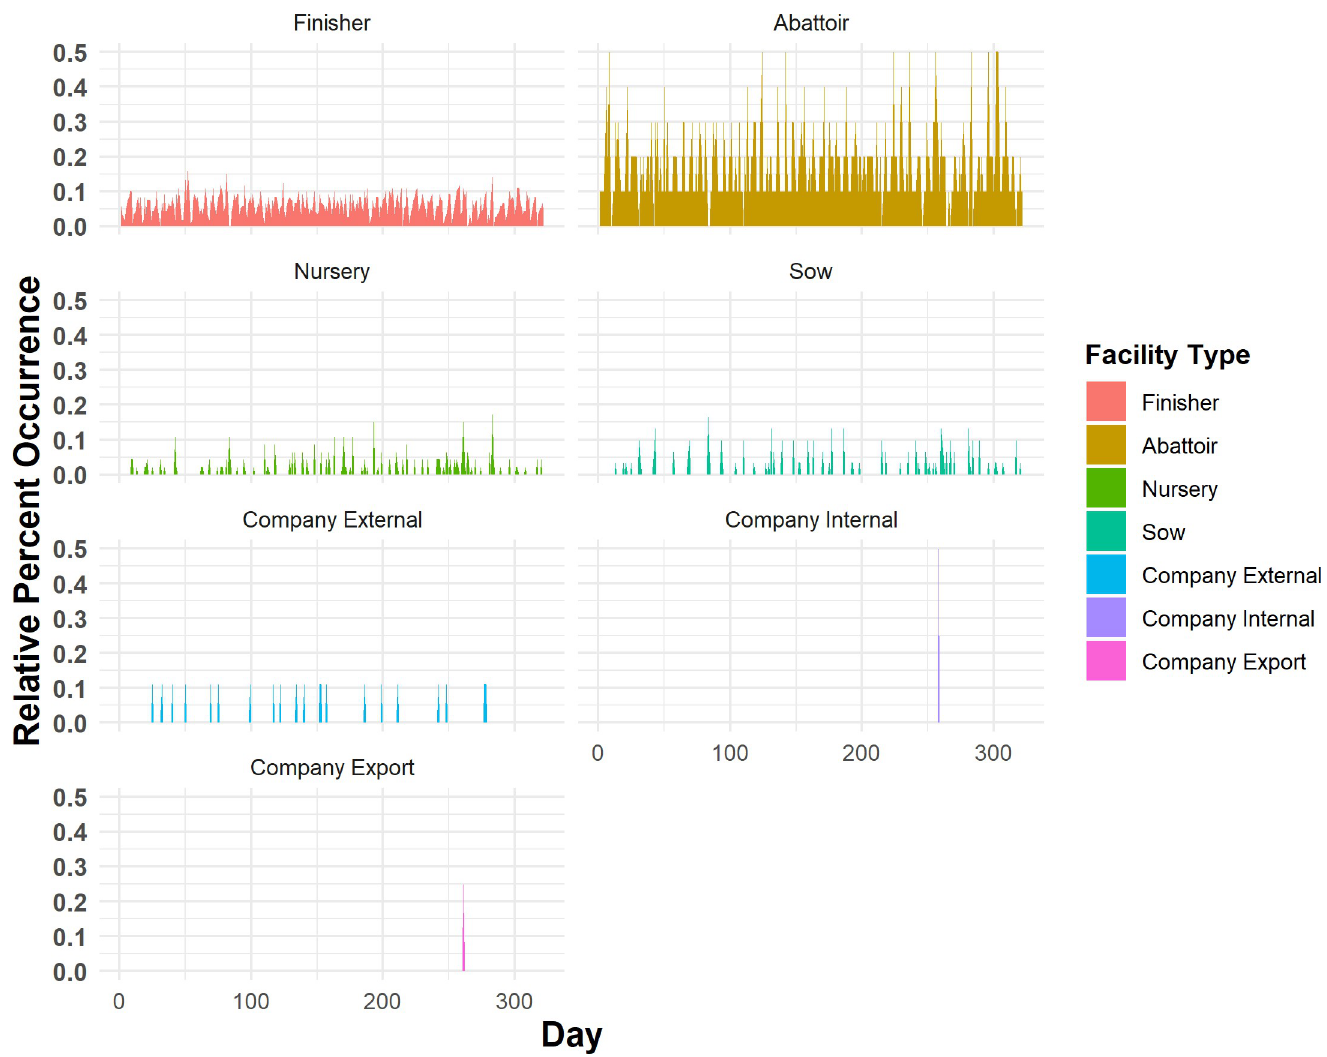
Fig 8. Daily one-mode network relative percent occurrence of facility types within the daily maximum weak component, calculated based on the total number of each facility type within the source population.